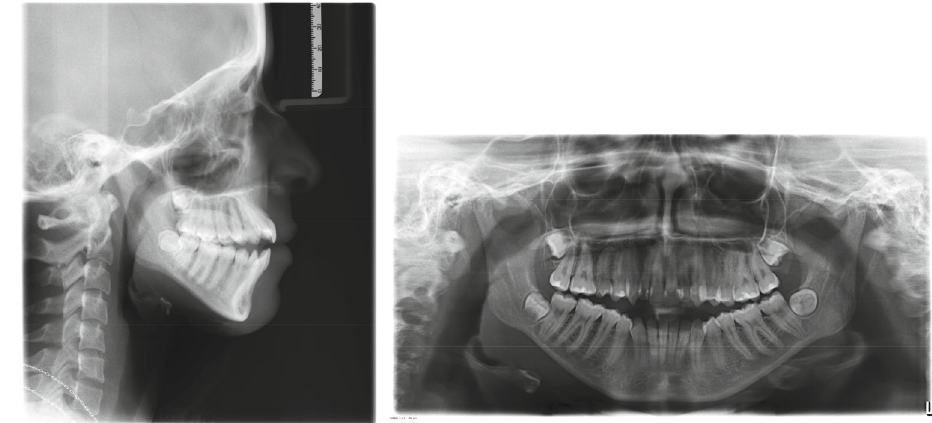
Figure 3: Pretreatment cephalometric and panoramic